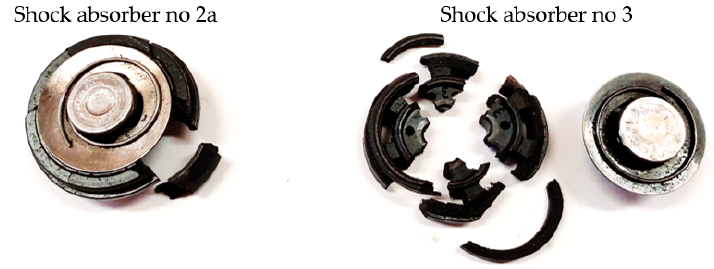
Figure 3. Characteristics of the shock absorber: 1—new, 2—used functional, 2a—used defective, 3—defective.